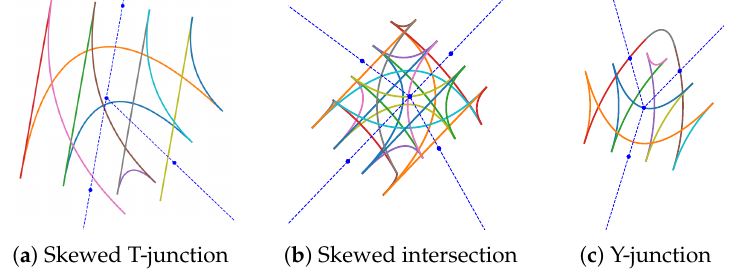
Figure 5. Examples of B-spline approximations of junctions with